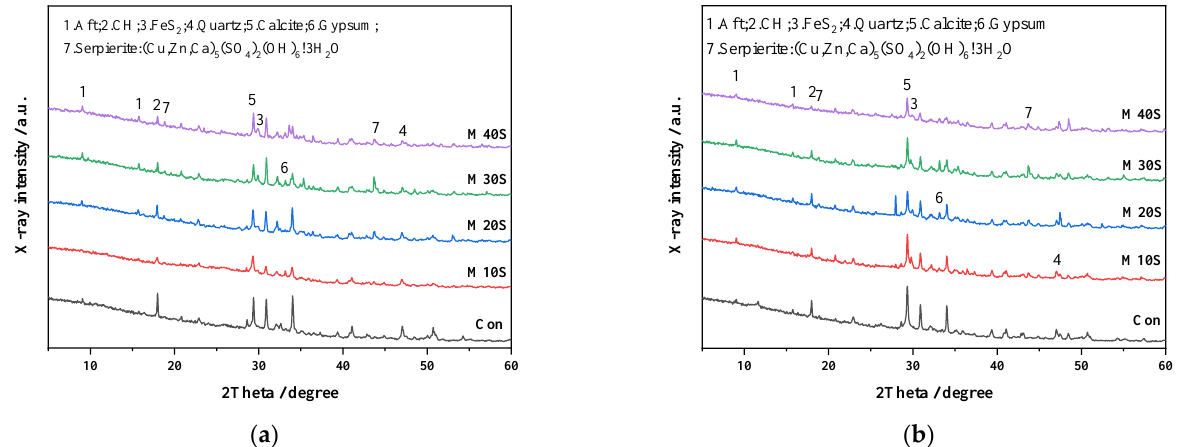
Figure 6. XRD patterns of hydration products of mortars with STs at different curing times: ( a ) 7 and ( b ) 28 days.